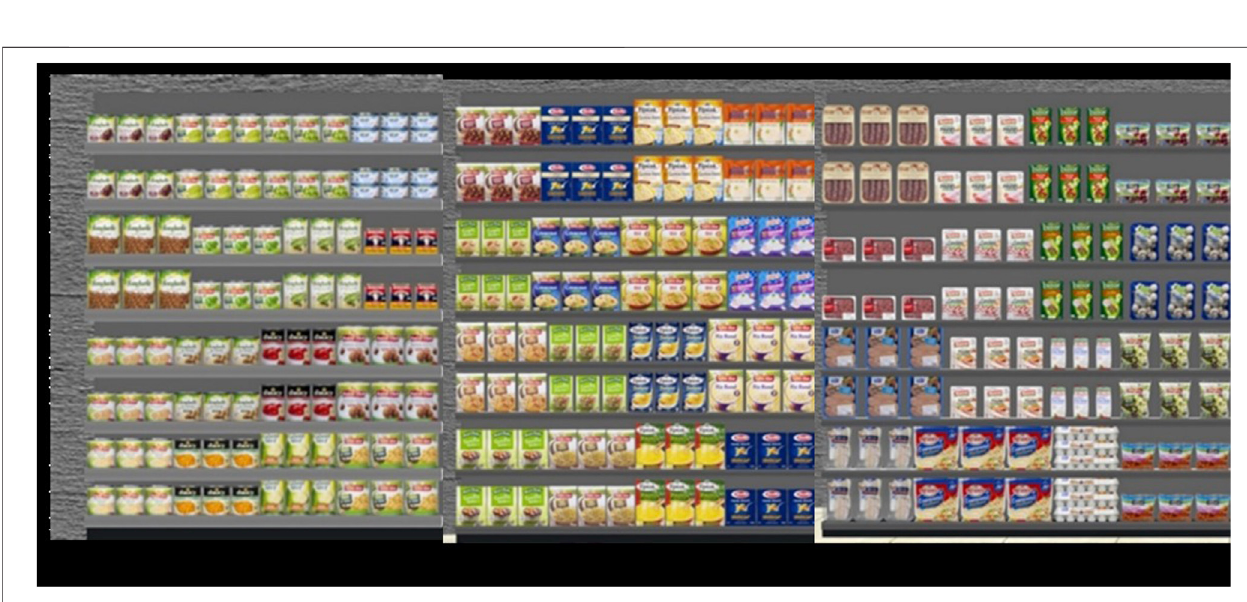
Frontiers in Virtual Reality |